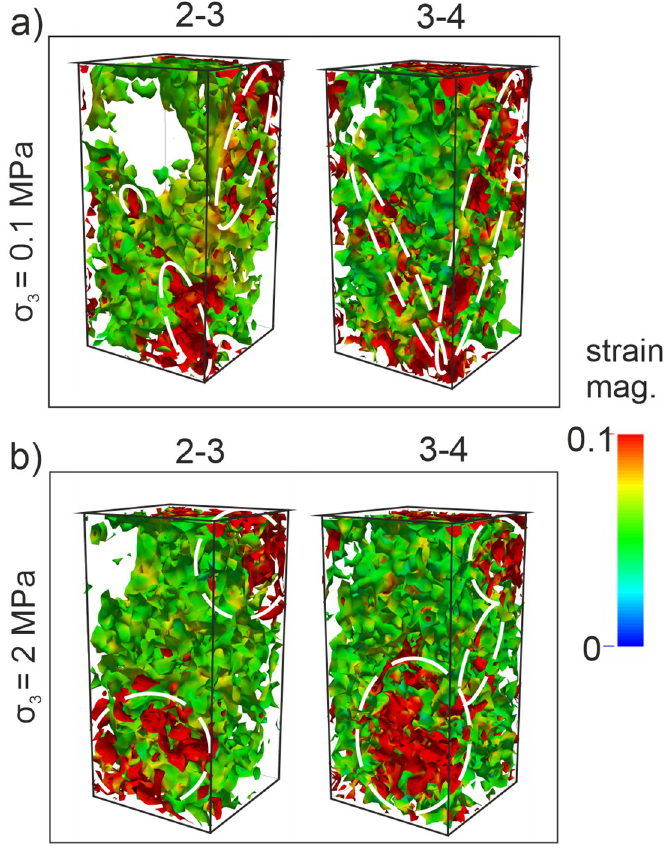
Fig 7. Strain fields computed between (2–3 and 3–4) in the 3D DEM simulations. (a) σ